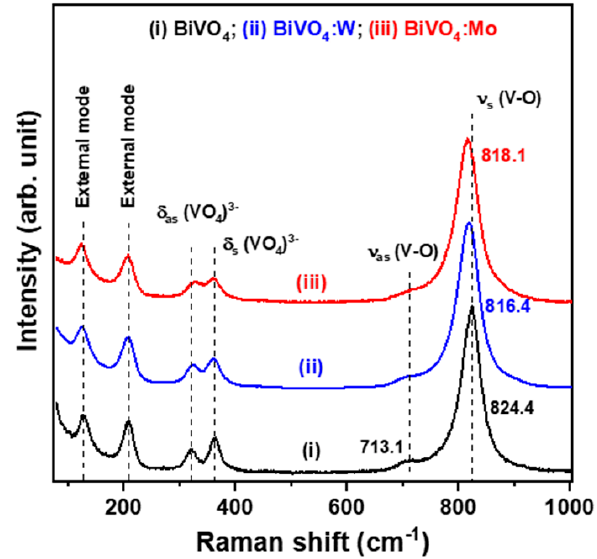
6 of 14 Figure 4. ESR spectra of undoped and impurity-doped BiVO 4 powder samples. The chemical structures of the BiVO 4 -based nanoparticles were identified by the Ra- man analytical technique, and three Raman spectra are presented in Figure 5. The intense band centered at 824.4 cm − 1 correlated with the symmetric V-O stretching mode ( ν s ), and a weak signal located at the low wavenumber side shoulder (713.1 cm − 1 ) was assigned to the anti-symmetric V-O stretching mode ( ν as ) for the pristine crystalline BiVO 4 particles [27]. The spectra related to the symmetric and anti-symmetric bending modes ( δ s and δ as ) of the vanadate anion (VO 43 − ) were found at 363.4 cm − 1 and 321.3 cm − 1 , respectively. In addition, two external modes attributed to rotation and translation were detected at 207.0 cm − 1 and 121.7 cm − 1 , individually. It is well known that the Raman band position, namely the peak wavenumber of the Raman band, is strongly related to the short-range order, and also that the width of the Raman band, namely the full width at half maximum (FWHM), is sensitive to lattice defects and structural disorder, crystallinity, and particle size [8]. The peak position of the most intensive Raman band of the two impurity-doped powder samples shifted toward the low wavenumber side as compared with that of the un-doped powder sample (Figure 5 and Table 1), indicating that the short-range symmet- ric stretching mode of the VO 4 tetrahedra in the structure of monoclinic BiVO 4 turned into a more regular state [28]. The FWHMs of the most intensive Raman bands for the BiVO 4 ,